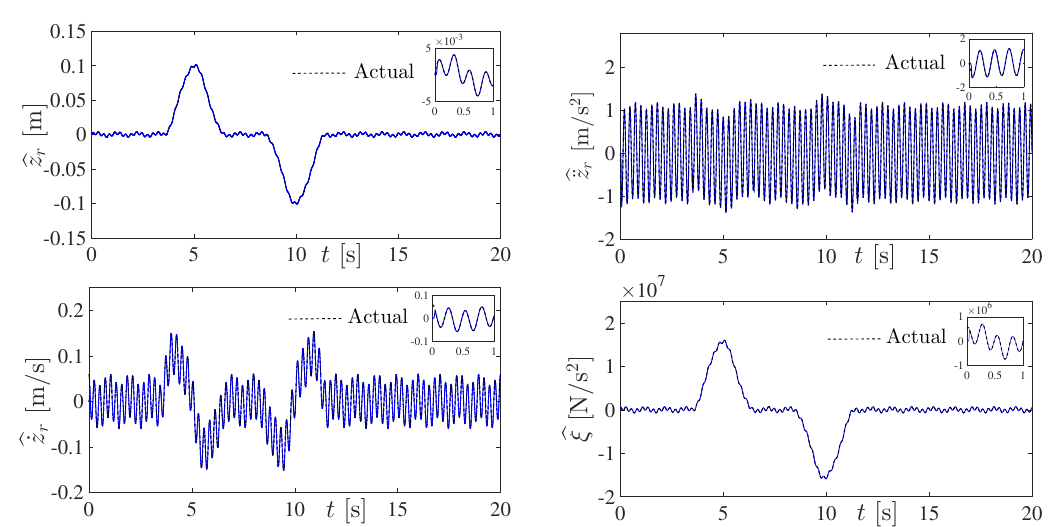
Figure 8. Online estimation of disturbance trajectories induced by irregular road